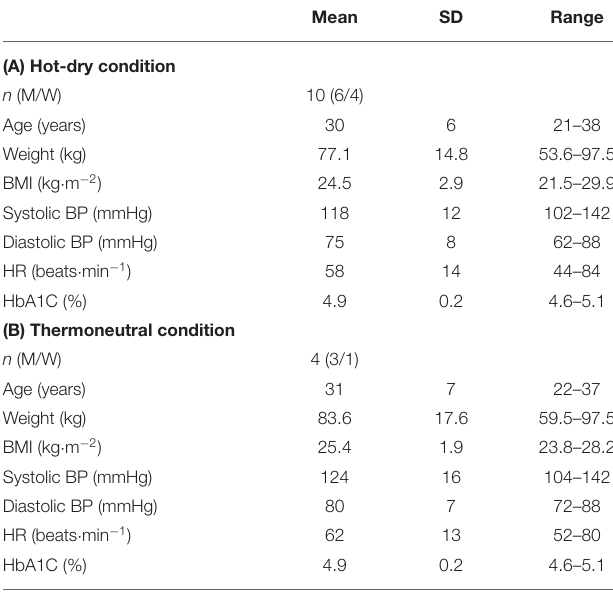
TABLE 1 | Subject characteristics for (A) hot-dry condition and (B) thermoneutral